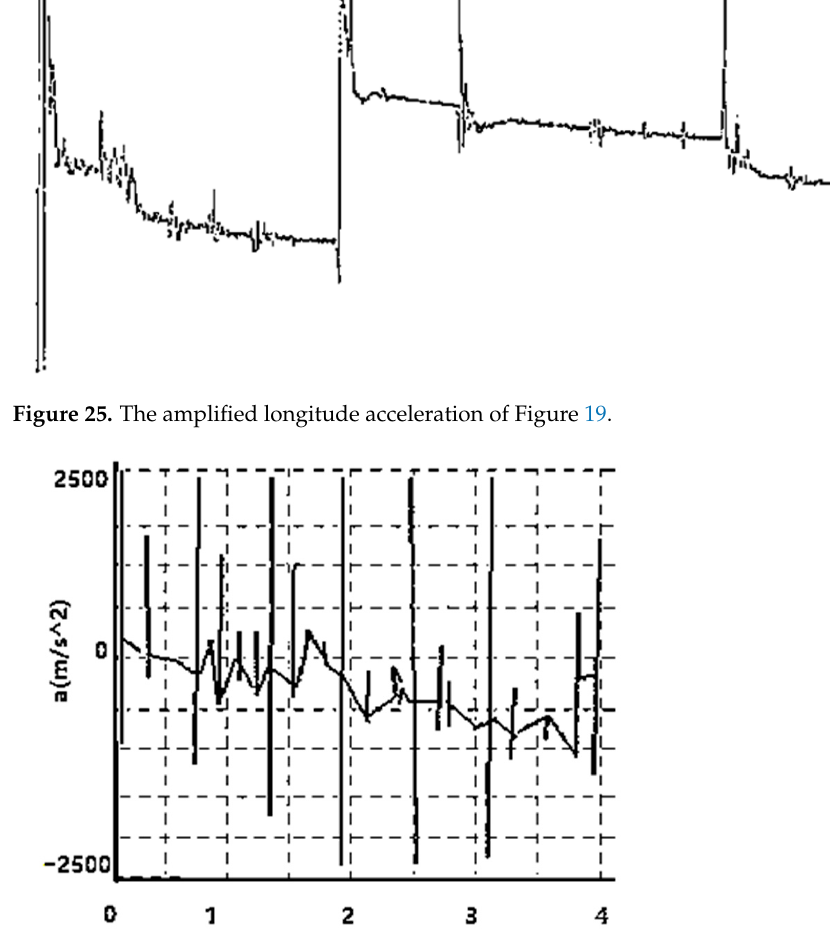
Figure 26. The experimental acceleration curve of the bolt body.